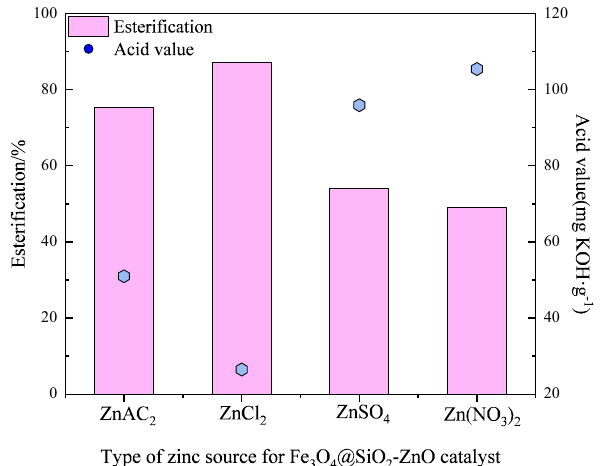
Figure 4: The e ff ect of di ff erent zinc sources on the reaction of rosin glycol esters ( rosin 15.0 g, ethylene glycol 1.7 g, catalyst 0.2 g, T 270°C, t 5 h ) .